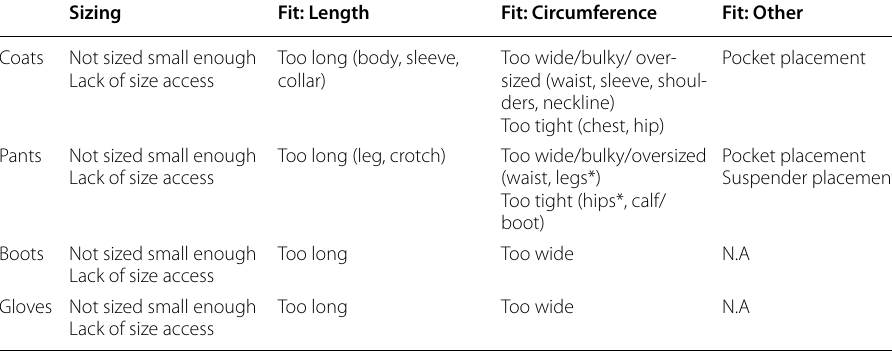
Information is from Boorady et al. (2013), Hulett et al. (2008), McKinney et al. (2021), Park et al. (2014), Park and Langseth- Schmidt (2016) * McKinney et al. reported mixed findings